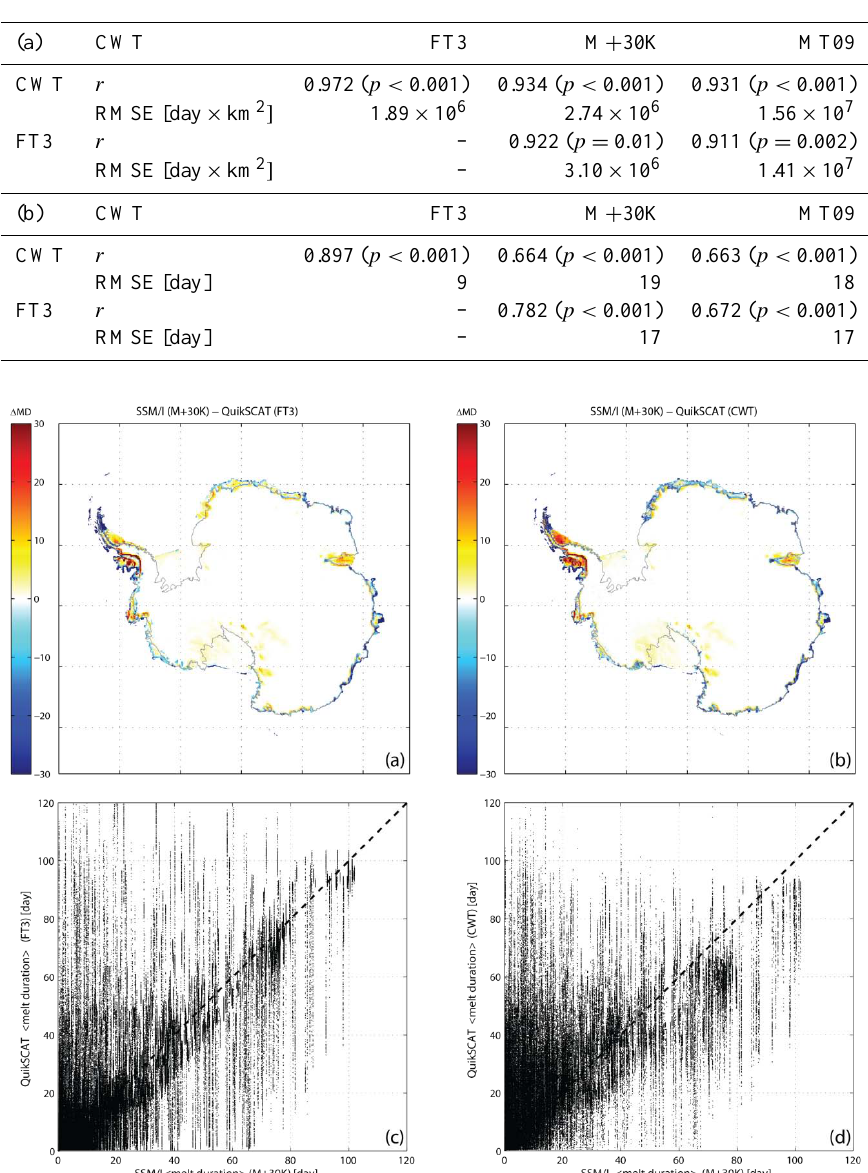
Fig. 9. The difference in average melt duration ( 1 MD = MD SSM / I − MD QuikSCAT ) over the period of 1999–2009 between the up-sampled passive microwave SSM/I data set, where melt is estimated using the M + K30 approach, and the enhanced-resolution QuikSCAT scatterome- ter data set, where melt is estimated using the (a) FT3 and (b) CWT methods. Per-pixel scatterplots of average melt duration between SSM/I (M + 30K) and the (c) FT3 and (d) CWT